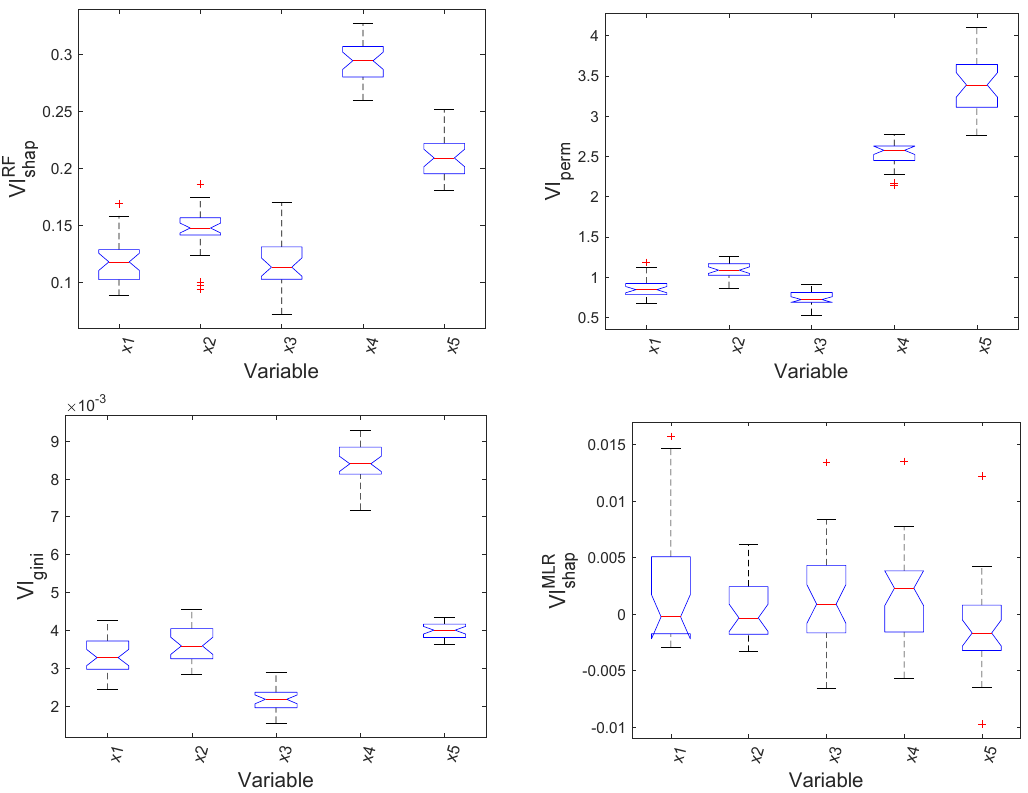
Figure 7. Variable importance analysis with the Shapley regression forest ( top , left ), permutation with the random forest ( top , right ), Gini index with the random forest ( bottom , left ), and Shapley regression with a linear model ( bottom , right ), based on 30 runs.